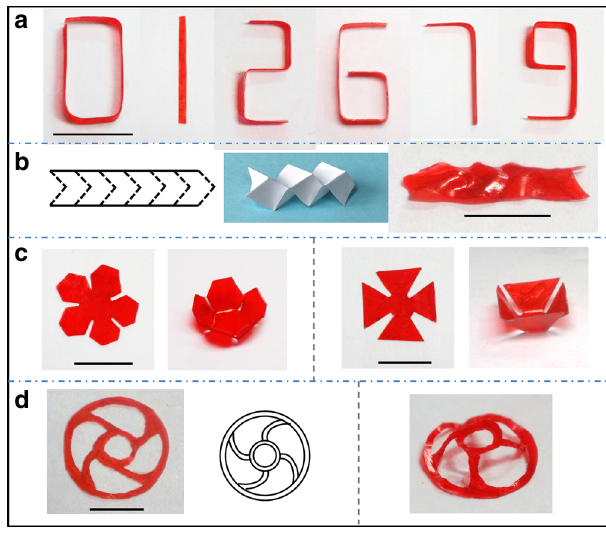
Fig. 3 Solvent-induced shape programming by origami and kirigami. a Digital numbers formed by origami from a strip. Scale bars: 1 cm. b A crease structure obtained by Miura-origami. (left panel: folding along with the dotted line; middle panel: illustration of a crease structure; right panel: the obtained crease-structure.) Scale bars: 1 cm. c Assembled 3D structures by origami and kirigami. Scale bars: 1 cm. d A steering-wheel-like 3D shape obtained by kirigami. (left panel: a cut fl at steering-wheel-like fi lm; right panel: the obtained 3D structure.) Scale bars: 1